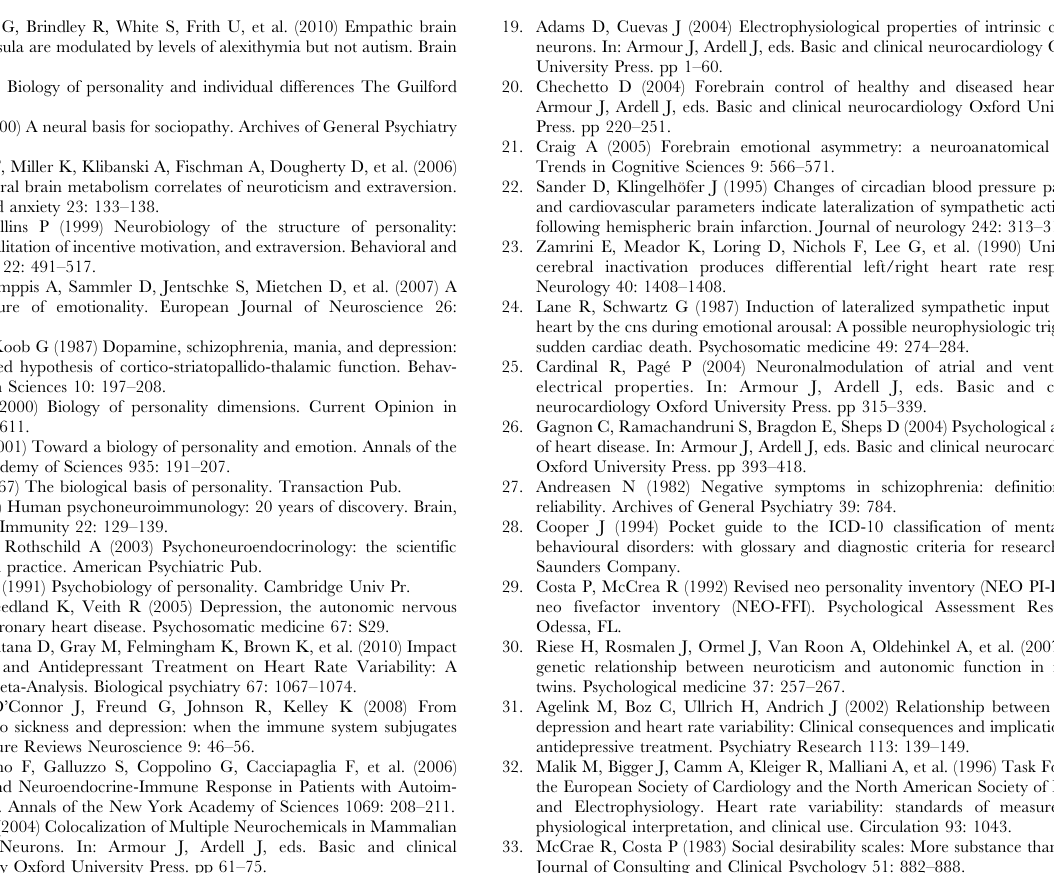
upper and lower quartiles of standard agreeableness scores (a), or upper and lower quartiles of standard positive emotion scores (b), predictor variables were the absolute ECG amplitude values, as well as body height, weight, and BMI. Abbrevations of ECG waves as in Table S1. (PDF) Table S4 Items for which the scores between the two E k groups ( E k values above and below the median of E k values) differed with effect sizes of Cohen’s d § .2. A plus sign indicates that scores were higher (‘‘agree’’) for individuals with lower E k values, the minus sign indicates that scores were lower (‘‘disagree’’) for individuals with lower E k values. For example, individuals with lower E k values had higher scores agreeing to the statement of not being a cheerful optimist. Cohen’s d was computed using Hedges’ bias correction. When comparing the scores of these items between groups using two-samples t { tests, p { values were v : 05 in each of the tests.